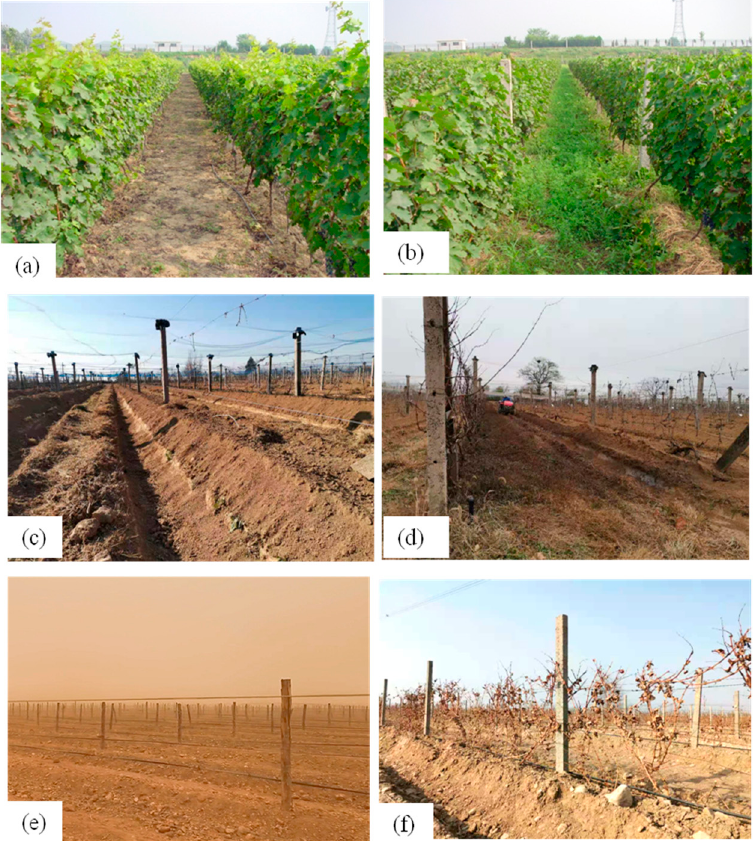
Figure 3. ( a ) The traditional clean tillage vineyard. ( b ) The grass covered vineyard. ( c ) Vineyard soil burial overwintering. ( d ) Vineyard sprayed with BLF overwintering. ( e ) No shoots vineyard after extreme wind erosion. ( f ) Shoots windbreak in